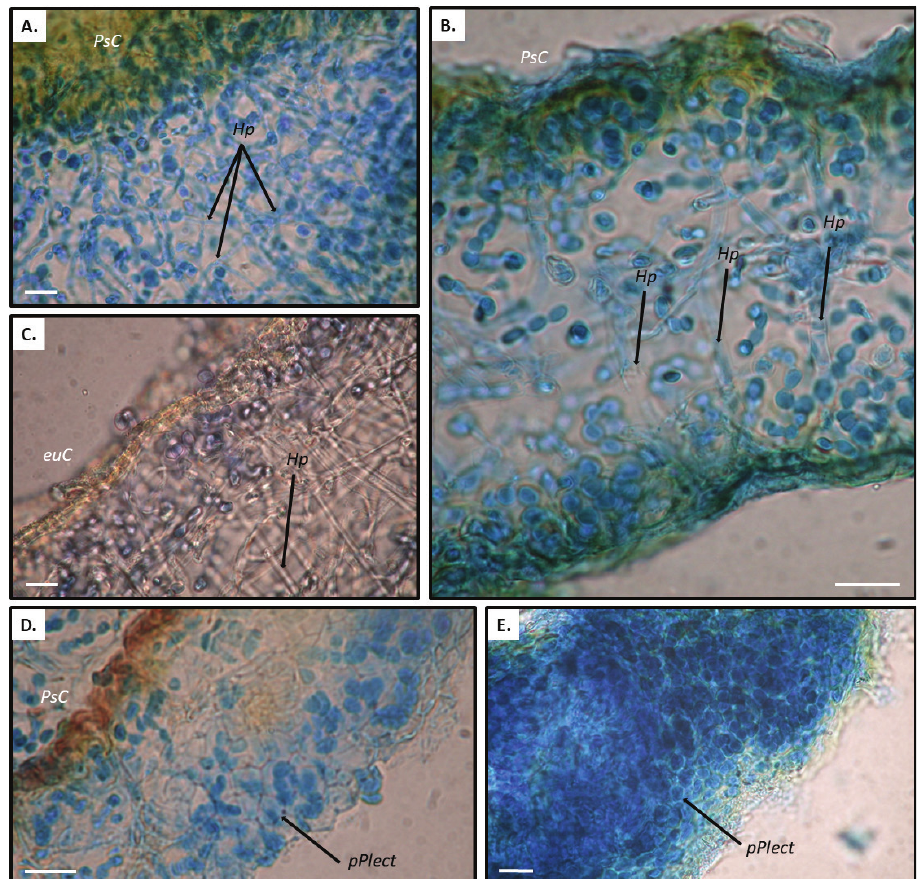
Figure 6. Thalli, transversal cross-sections: A Thallus with pseudocortex and densely interwoven hyphae ( Rostania quadrifida , McCune 2744, UPS) B Thallus with pseudocortex and straight and unbranched hyphae which are perpendicular to the surface ( Rostania paramensis , Palice 2796, holotype of Collema paramense ) C Thallus with eucortex and straight and unbranched hyphae which are perpendicular to the surface ( Leptogium azureum , Tehler 3140, S) D Thallus with eucortex and paraplectenchymateous throughout ( Scytinium sp. Palice 2273) E Thallus paraplectenchymateous throughout ( Rostania occultata var. populina , Llop 56060303, S) A–E in lactic blue C in water. euC = eucortex, PsC = pseudocortex, Hp = hyphae, pPlect = paraplechtenchyma. Scale bar = 10